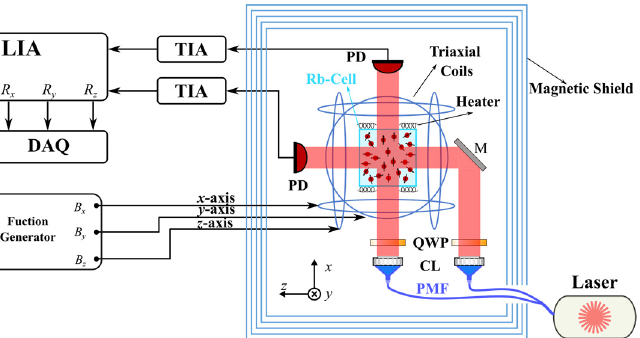
Figure 3. The setup of the dual-axis atomic magnetometer. PMF: polarization-maintaining fiber; CL: collimating lens; QWP: quarter-wave plate; PD: photodiode; TIA: trans-impedance amplifier; LIA: lock-in amplifier; DAQ: data acquisition equipment.